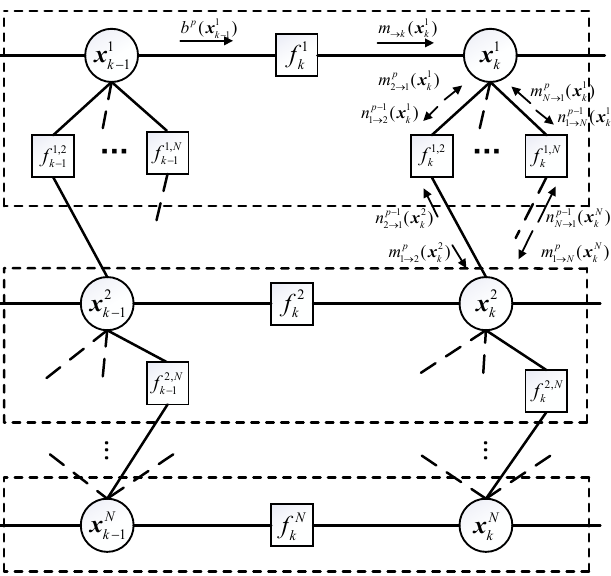
in k = f ( z i | x i ) f ( x i | x i ) , x i k k k k − 1 k k − 1 . The arrows indicate the direc-